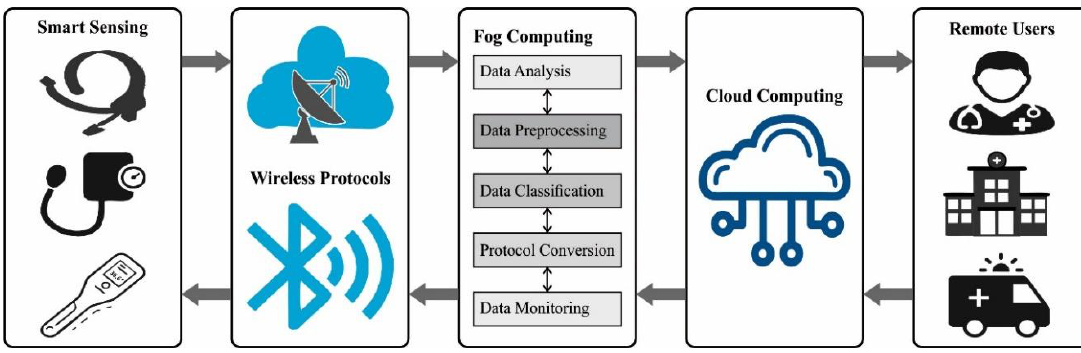
Figure 1. Emergency Department Process.